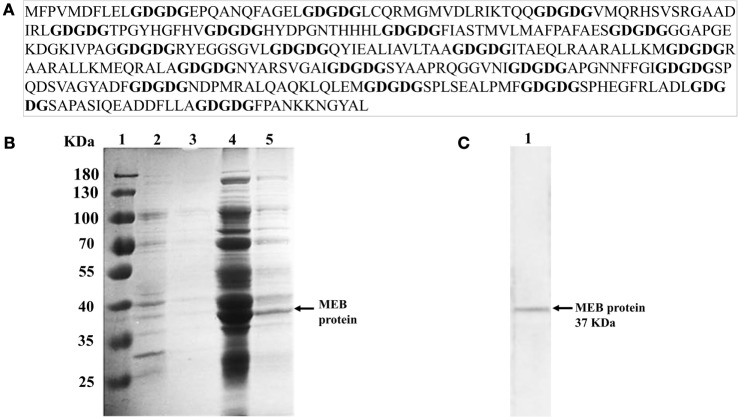
MEB DNA vaccine design and identification of rMEB protein. (A) Multi-epitope vaccine sequence spaced by GDGDG linker sequence. (B) SDS-PAGE analysis of rMEB. Lane 1, marker; lane 2, total proteins obtained from insoluble extract from Escherichia coli transformed with pQE80L-MEBe plasmid; lane 3, eluent from Ni2+-chelated affinity chromatography of the insoluble extract from E. coli; lane 4, total proteins obtained from the soluble extract from E. coli transformed with pQE80L-MEBe plasmid; lane 5, eluent from Ni2+-chelated affinity chromatography of the soluble extract from E. coli. (C) Western blot analysis of rMEB with anti-His-tag monoclonal antibody.